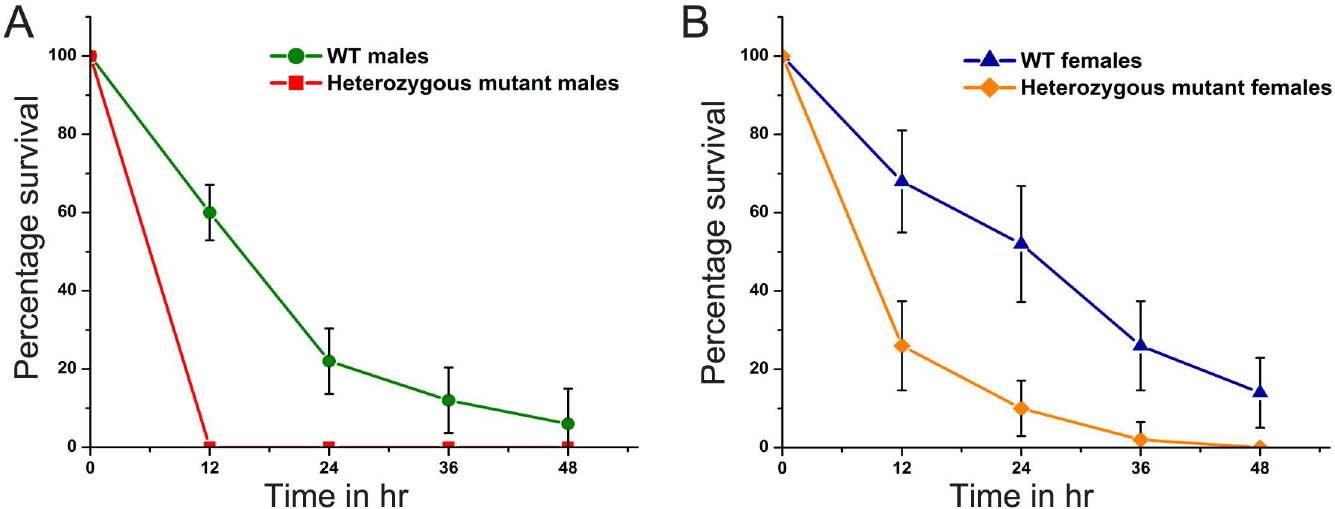
Fig 12. Decreasedresistance to paraquat-induced oxidative stressin Digitor mutant flies. (A) Survival rates of wild-typeand EP(3)3709 heterozygous male flies 12, 24, 36, and 48 hr after exposureto 20 mM paraquat.(B) Survival rates of wild-type and EP(3)3709 heterozygous female flies 12, 24, 36, and 48 hr after exposureto 20 mM paraquat. Each data point represents the averagesurvival rate from five independent determinations with S.D.